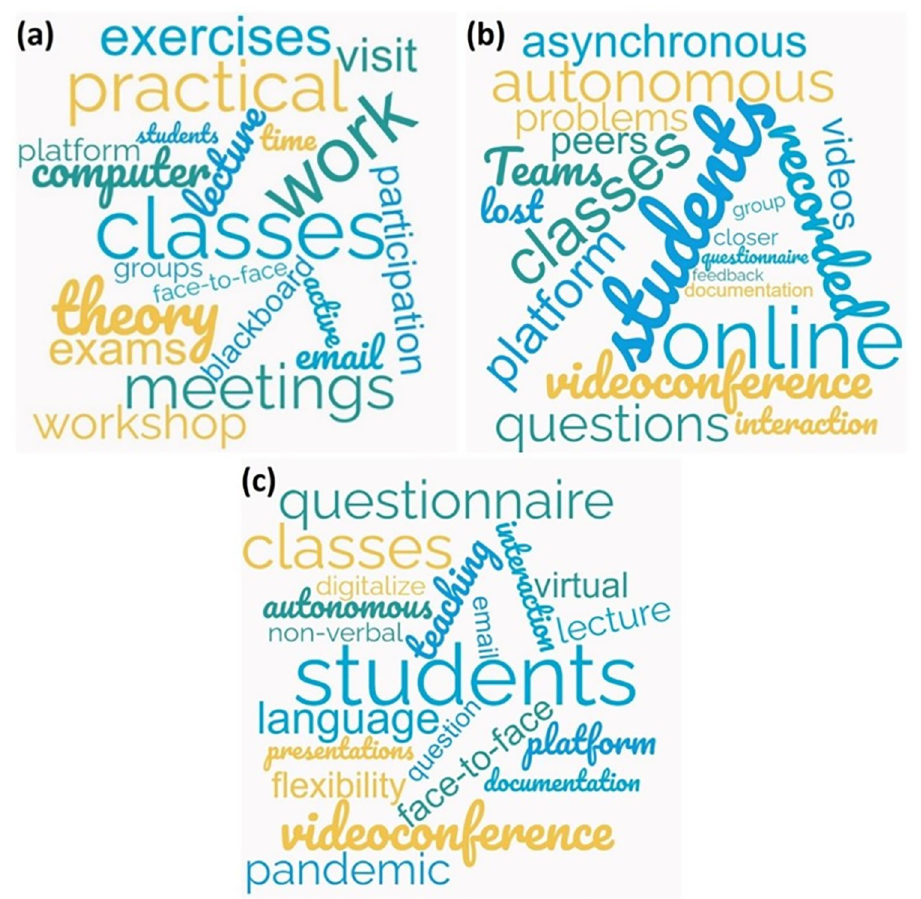
Fig 1. Word clouds of the teachers’ answers: (a) pre-COVID-19 pandemic and lockdown; (b) during COVID-19 lockdown; (c) post-COVID-19 lockdown.